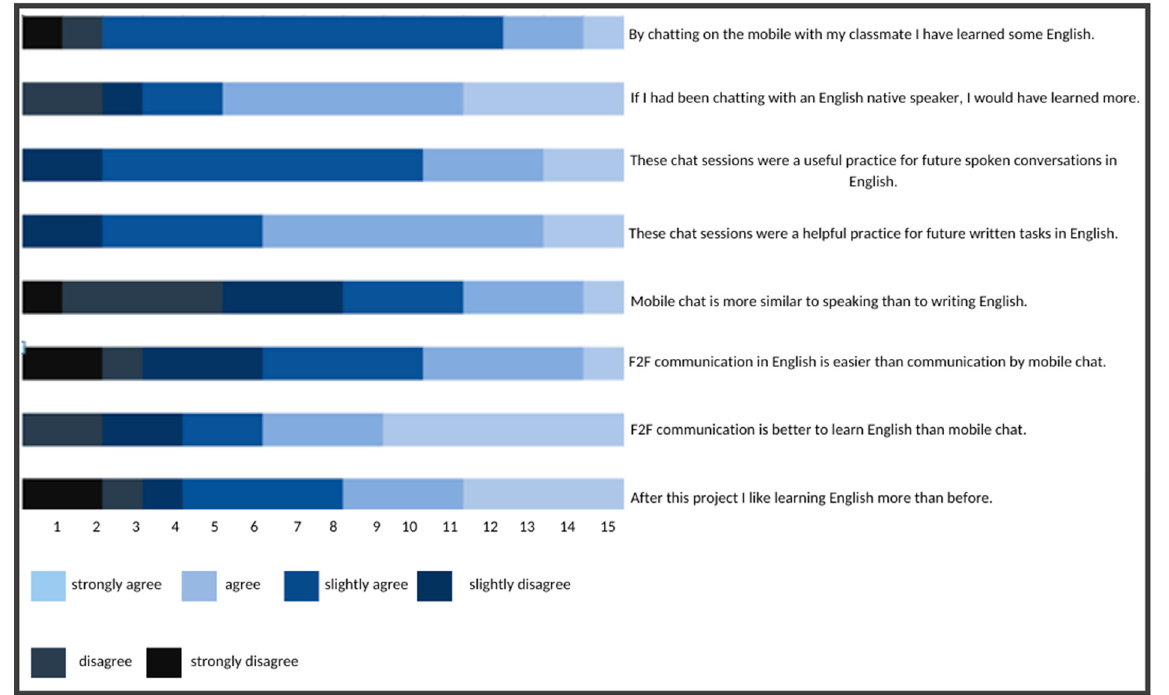
Figure 2. Frequency of rating on task perception questionnaire for all participants ( N = 15).